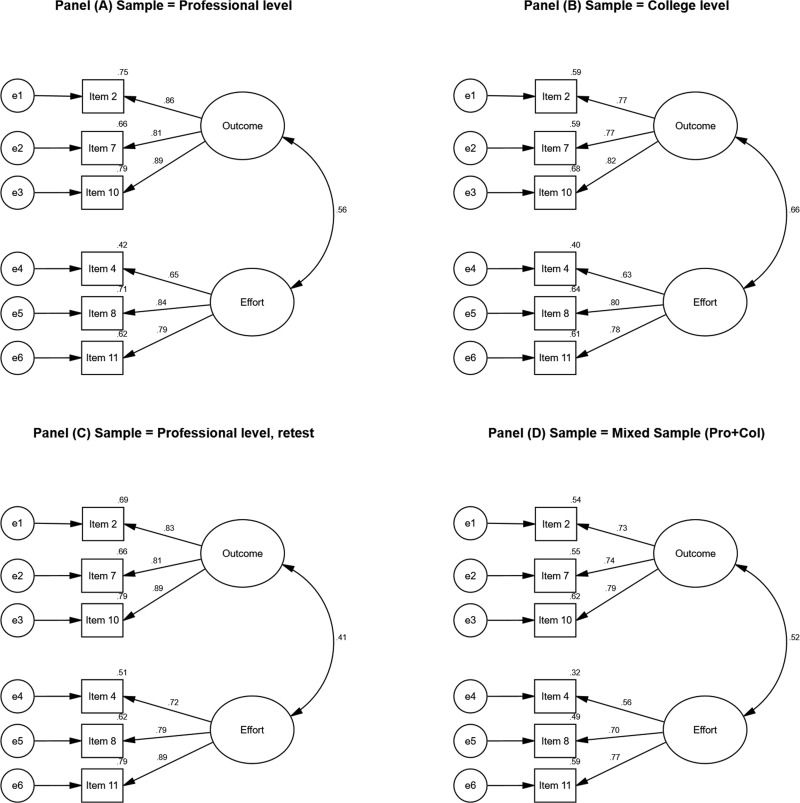
Best fitted model (Model #3 - 2-factor model) for samples 1–4. Standardized estimates are presented alongside squared multiple correlation for each item (upper left corner). All estimates are significant at the p < 0.001. Panel (A) presents results from the EFA analysis (Professional sample, N = 231); Panel (B), presents results from the CFA analysis (College sample, N = 222). Panel (C) presents results from the CFA analysis (Professional retest sample, N = 89); Panel (D), presents results from the CFA analysis (mixed sample, N = 139).